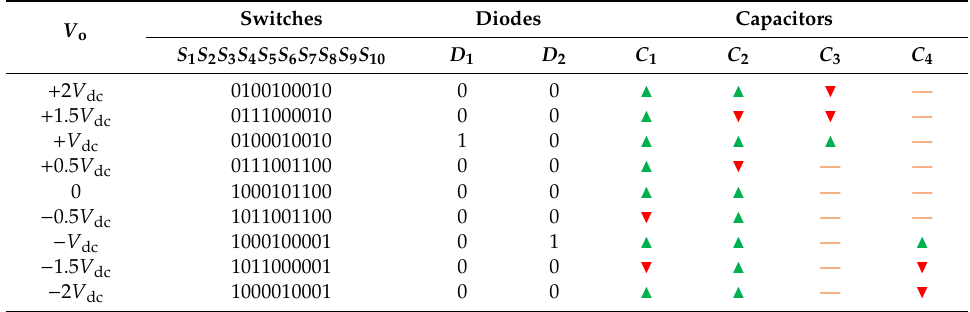
Table 1. States of devices in different modes.